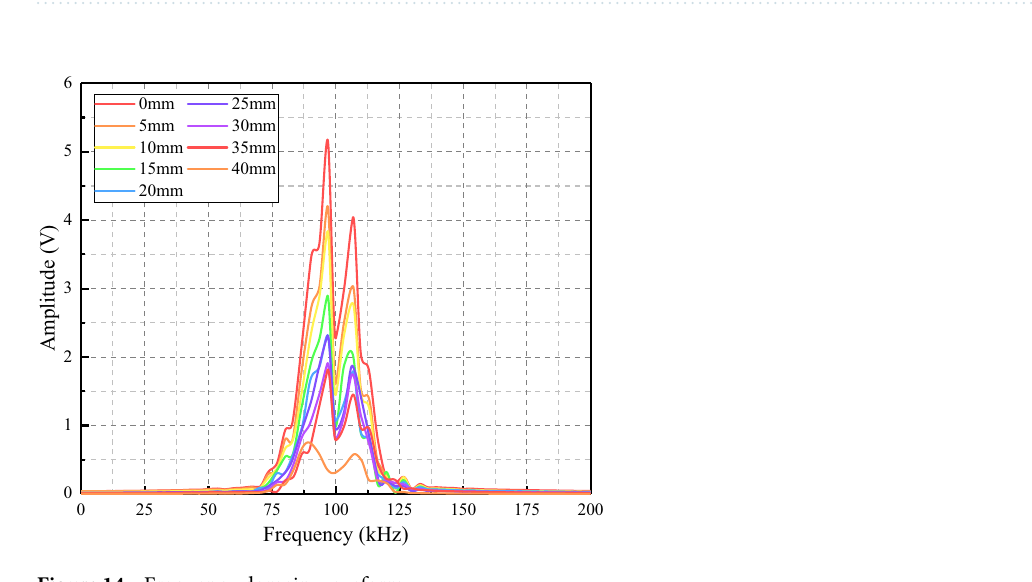
Figure 14. Frequency domain